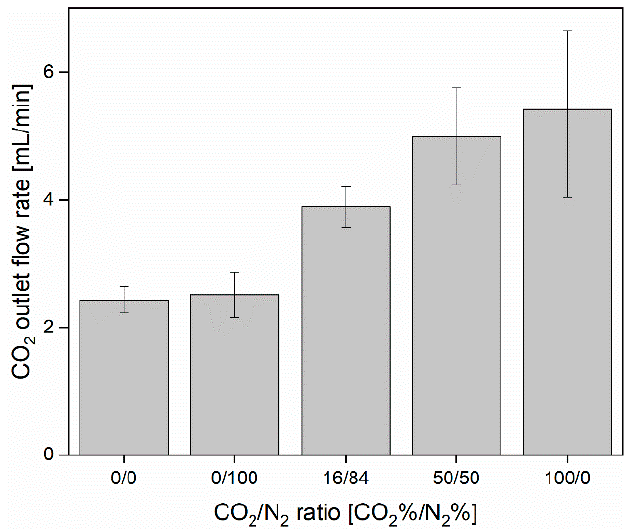
Figure 5. Average CO 2 flow for different compositions of inlet gas (experimental conditions: Q inlet = 20 mL/min, Q pump = 5 mL/min, J = 100 mA/cm 2 ).